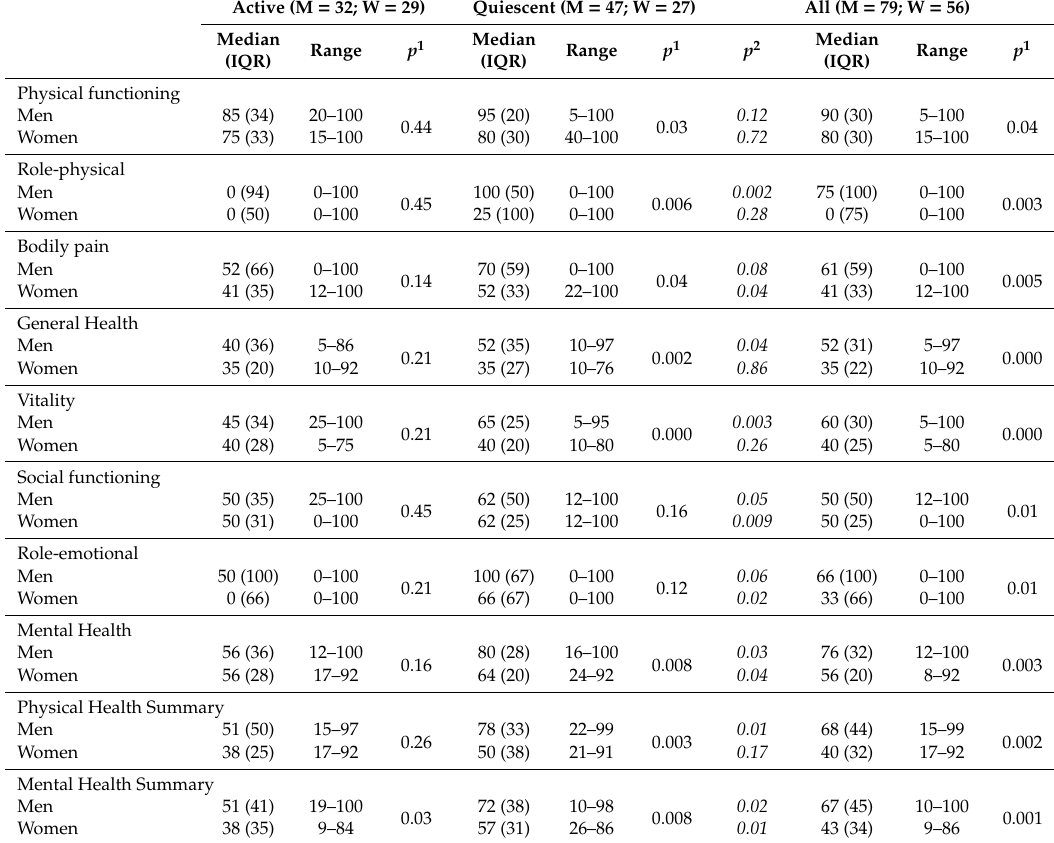
Table 2. Assessment of quality of life according to gender and disease